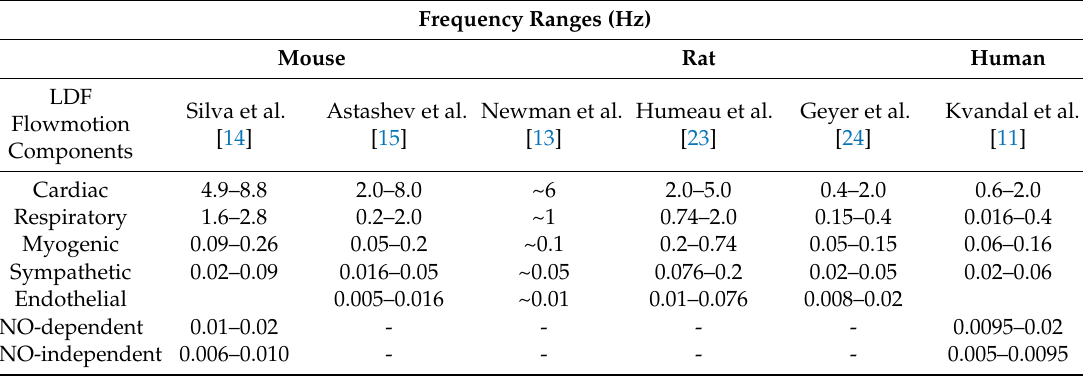
Table 2. Reported frequency ranges (Hz) for the LDF perfusion flowmotion components in mice (see also Figure 2b) and rats, with human ranges as